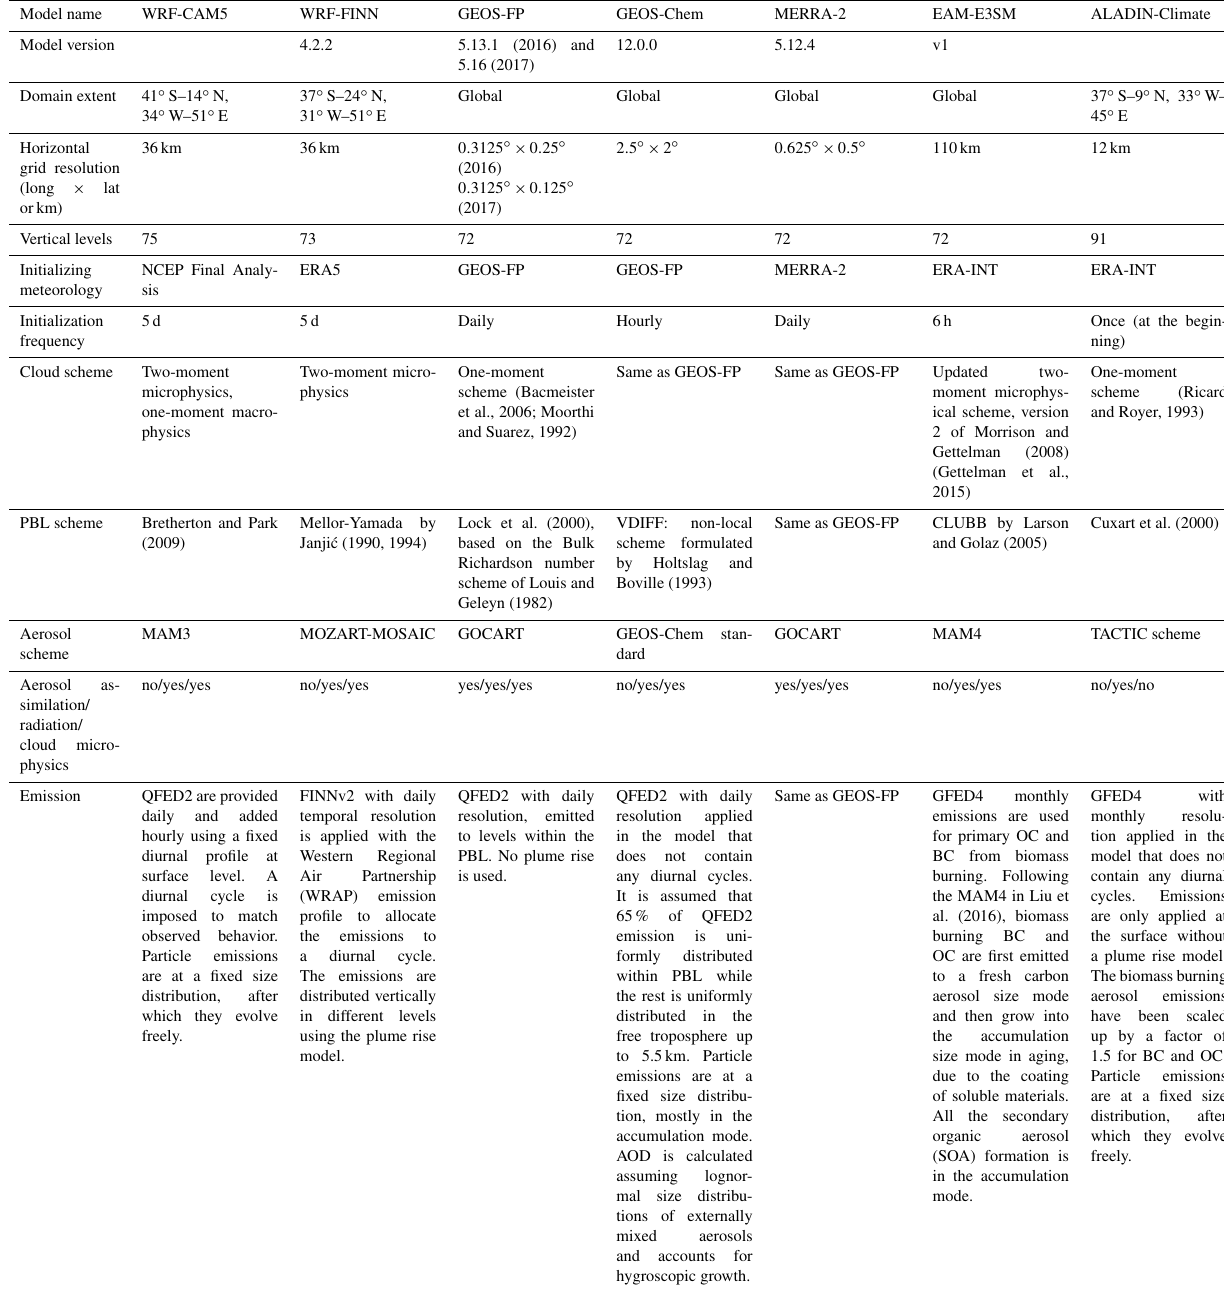
Table 1. General specifications including emission, transport, and deposition processes of the models in this study. The acronyms of GFED, FINN, and QFED stand for Global Fire Emission Database, Fire INventory from NCAR, and Quick Fire Emissions Dataset,